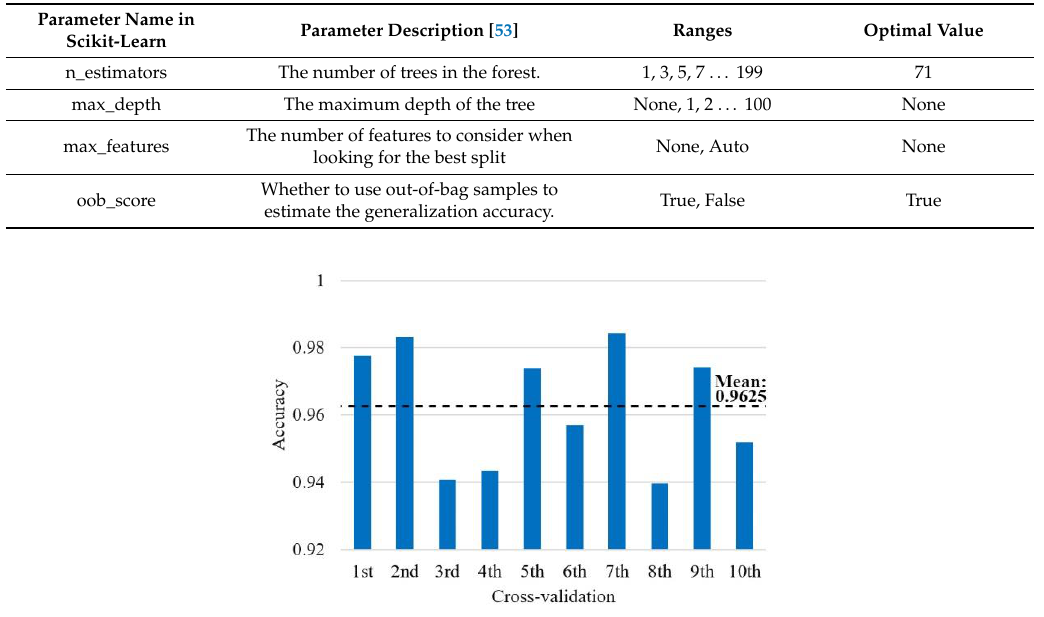
Figure 9. Cross-validation results of the optimal model ( x -axis represents the cross-validation times; y -axis represents the model accuracy; the black dashed line represents the mean of cross-validation results).